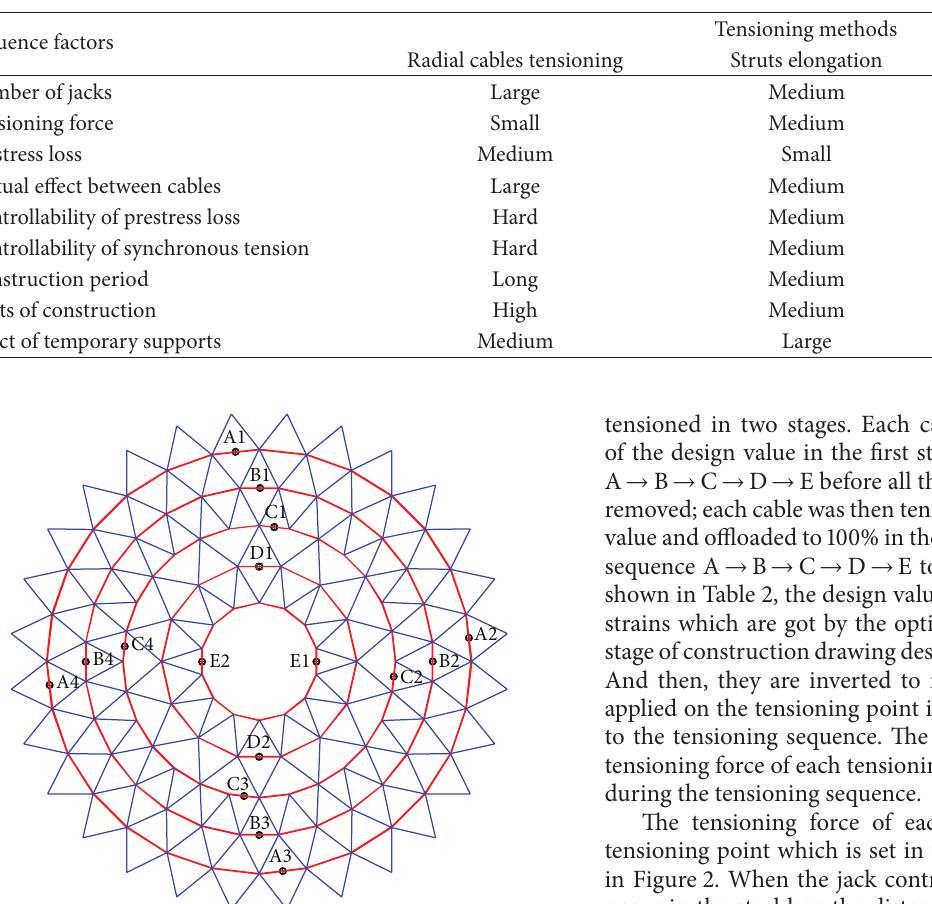
Table 1: Comparison of different tensioning methods.